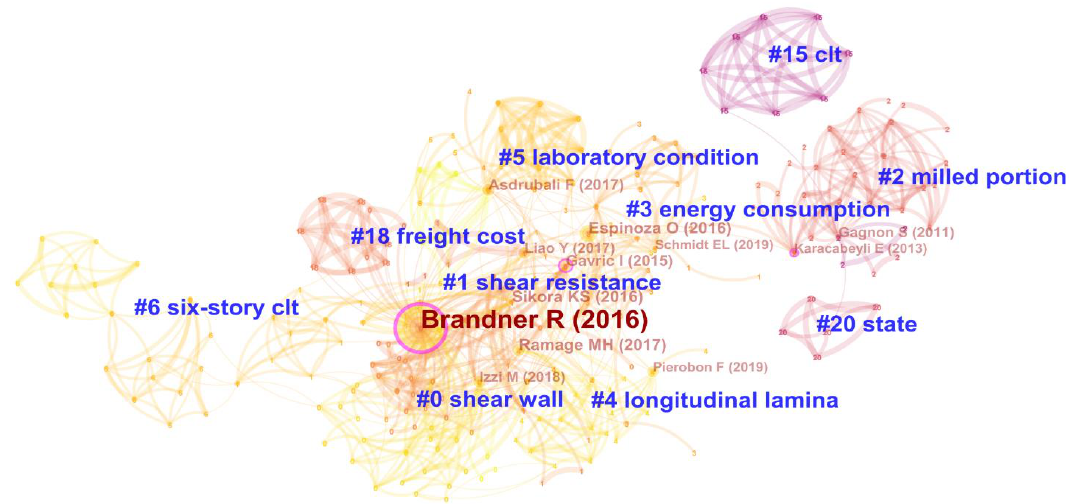
Figure 11. Abstract clustering network map of co-citations. Table 5. List of the top 25 most cited articles between 2006 and